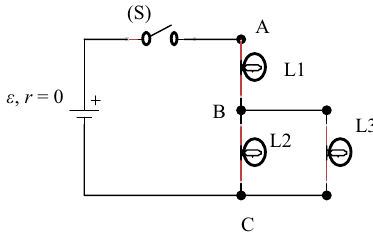
Fig. 11. The brightness of the